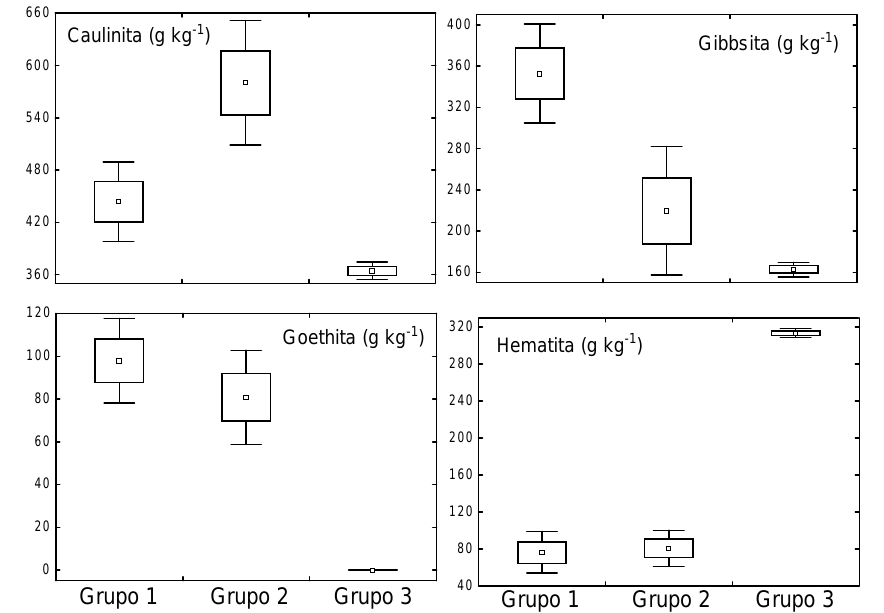
Figura 9. Médias, erro-padrão (box) e intervalo de confiança (barra de erro-padrão ××××× 1,96) de variáveis mineralógicas da fração argila de amostras de horizontes superficiais e subsuperficiais dos grupos de perfis de solo: 1 = solos de textura argilosa a muito argilosa, hipo a mesoférricos; 2 = solos de textura média a arenosa, hipoférricos; 3 = solos de textura argilosa a muito argilosa,